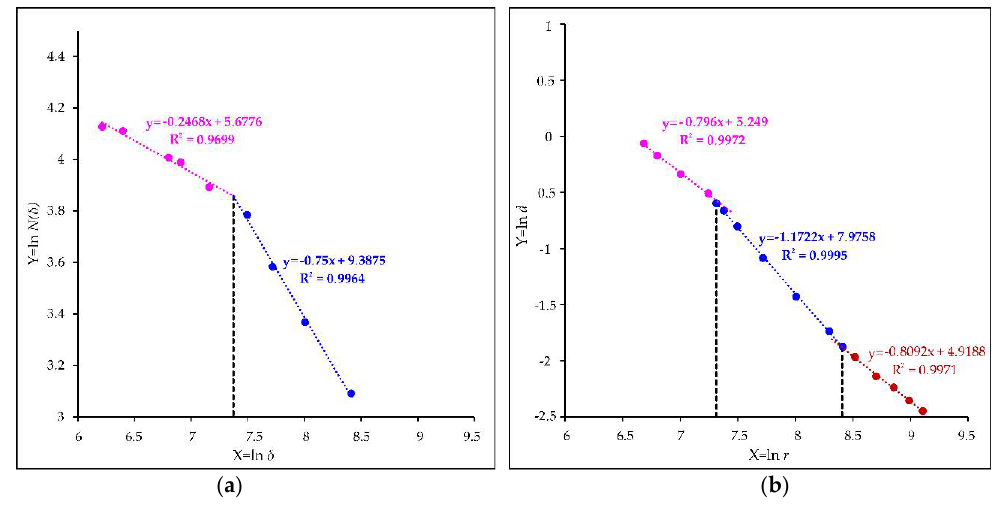
Figure 4. Log-log plot defining the fractal dimensions of spatial pattern of copper occurrences in the TOD: ( a ) box-counting linear relationship; and ( b ) radial-density linear relationship.